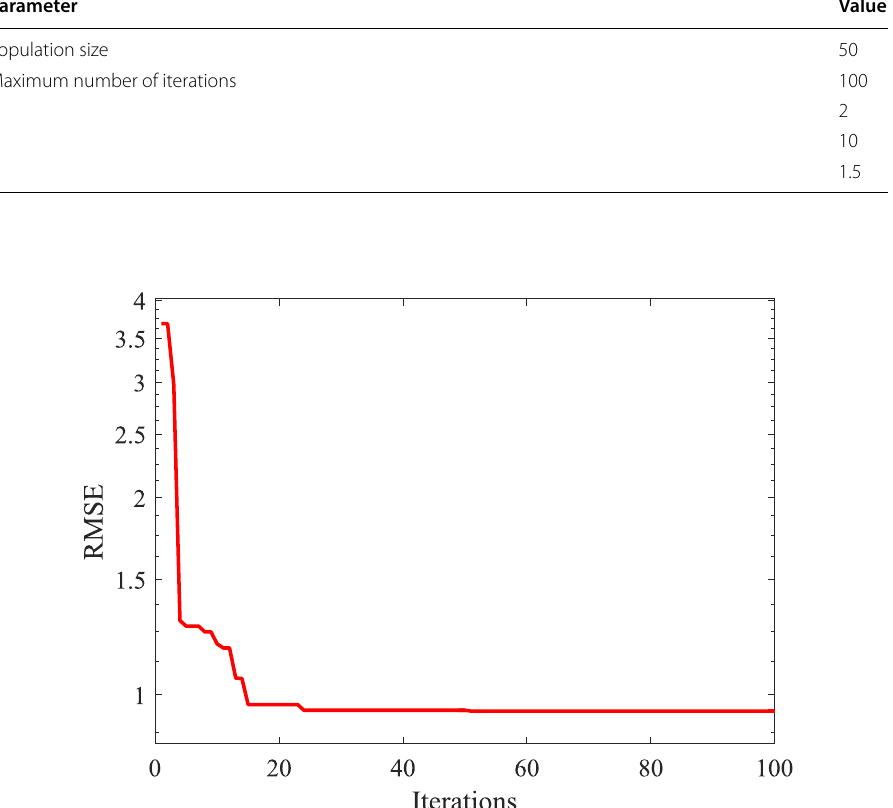
Fig. 6 Convergence curve of BES